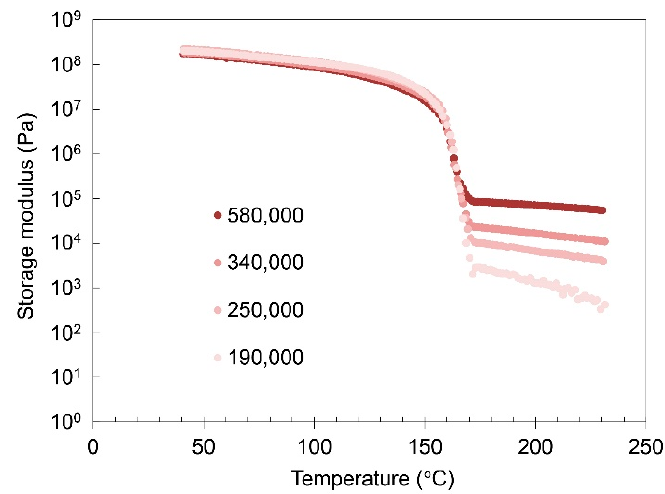
Figure 6. Storage modulus of iPP-solids with different molecular weights as a function of temperature.